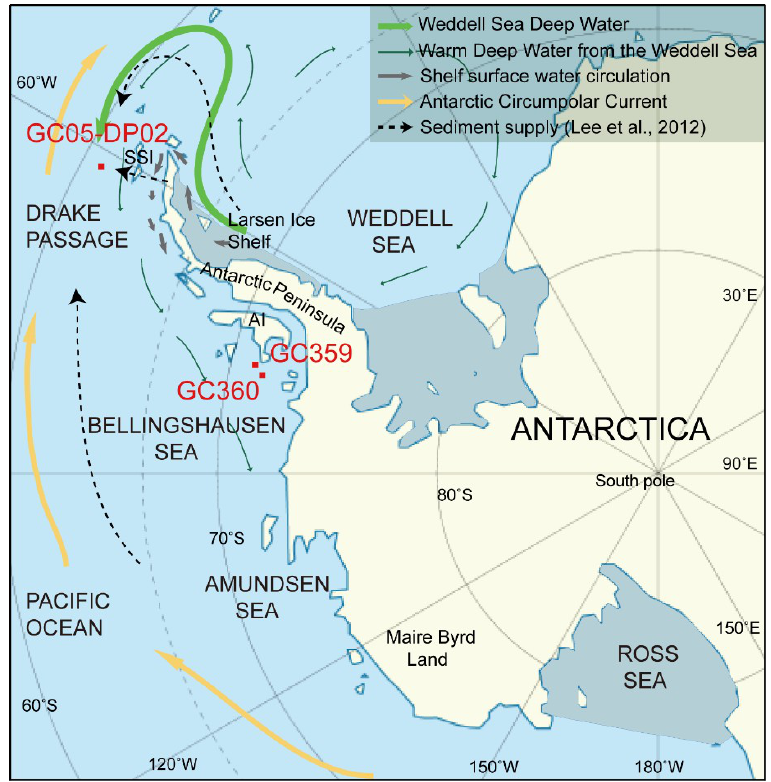
Figure 1. Location of core GC05-DP02 in southern Drake Passage and cores GC359 and GC360 on the shelf of the Bellingshausen Sea, Antarctica. Deep and shallow water circulation paths are from the modified of Hernández-Molina et al. (2006) [19]. SSI = South Shetland Island, AI = Alexander Island.